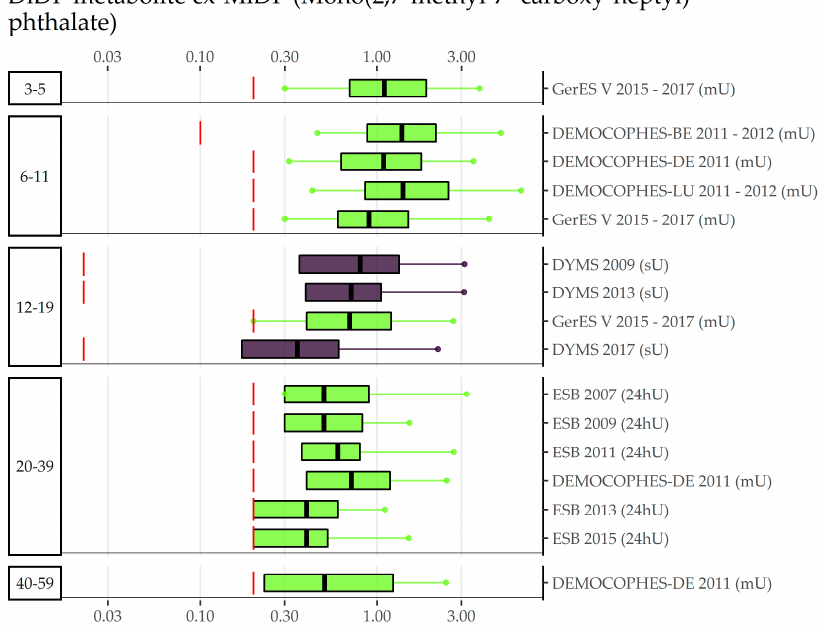
Figure 7. DiDP metabolite cx-MiDP concentration in µ g/L in boxplots. The box is based on P25, P50, and P75, and the whiskers are based on P5 and P95. Boxplots are presented separately by age groups; within age groups they are chronologically sorted by year of sampling. Colors of the boxplots refer to the data collection’s region (North = violet, South = blue, West = green, East = orange, Israel = dark red). Red lines denote LOQ/LOD for the respective study. Since percentiles are only available and displayed when they are above LOQ/LOD, the lower side of boxplots might be